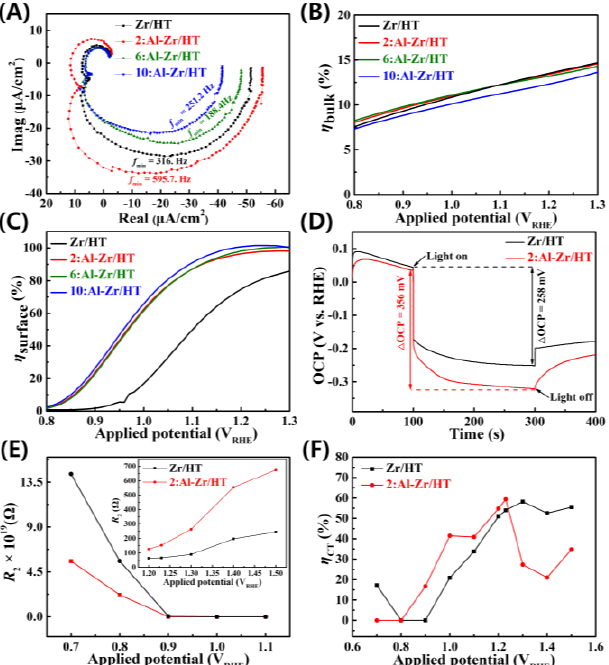
Figure 4. ( A ) The complex plane plots of the IMPS response at 1.0 V vs. RHE; charge separation efficiency ( B ) in the bulk, and ( C ) on the surface of the Zr/HT, 2:Al-Zr/HT, 6:Al-Zr/HT, and 10:Al-Zr/HT photoanodes; ( D ) open-circuit potential (OCP) vs. time using 1 M NaOH electrolyte; ( E ) R 2 data obtained upon fitting their respective Nyquist plots to the equivalent circuits, and ( F ) charge– transfer efficiency ( η CT ) at various potentials using 1 M NaOH electrolyte under 1-sun standard illumination conditions for the Zr/HT and 2:Al-Zr/HT photoanodes.